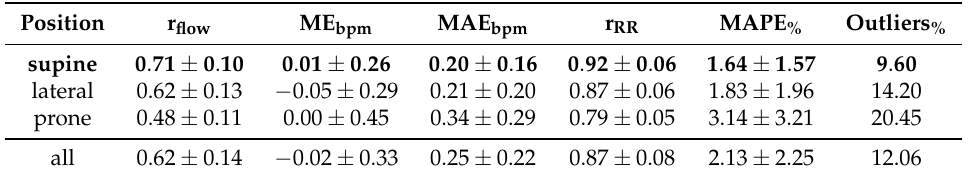
Table 5. Performances of the respiratory signal and rate estimations in the individual positions for minimum MAE bpm feature selection optimization. The percentage of outliers removed is